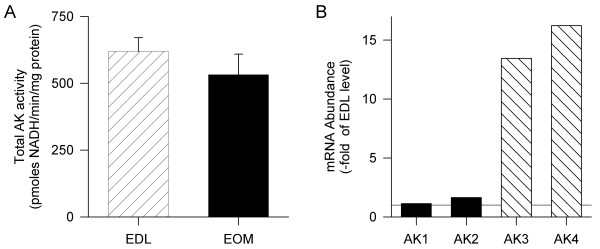
Upregulation of AK isoforms in rat extraocular muscle. (A) Total AK activity in EDL and extraocular muscles (n = 9, P > 0.35). (B) Relative abundance of mRNAs for four AK isoforms in extraocular muscle by quantitative PCR. Each sample includes pooled muscles from 4 rats. Data are mean -fold differences (3–4 samples) in AK isoform expression and normalized to EDL muscle = 1.0, shown by the horizontal reference line. The abundance of AK1 and AK2 mRNAs was not significantly different in extraocular and EDL muscles (black bars). AK3 and AK4 are expressed at significantly higher levels in extraocular muscle (13.5- and 16.2-fold greater than EDL, respectively).